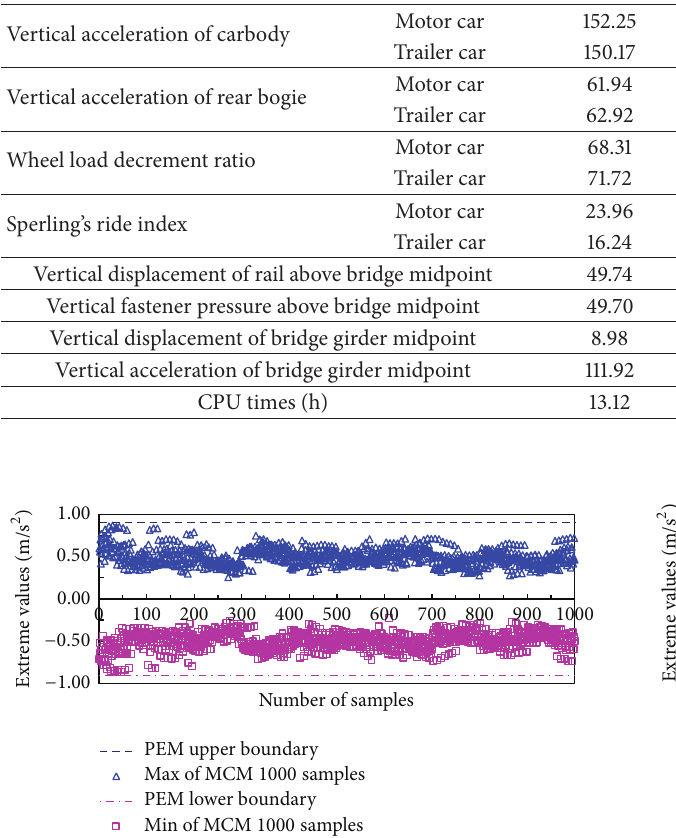
Figure 11: Comparison of rear bogie vertical acceleration of motor car.